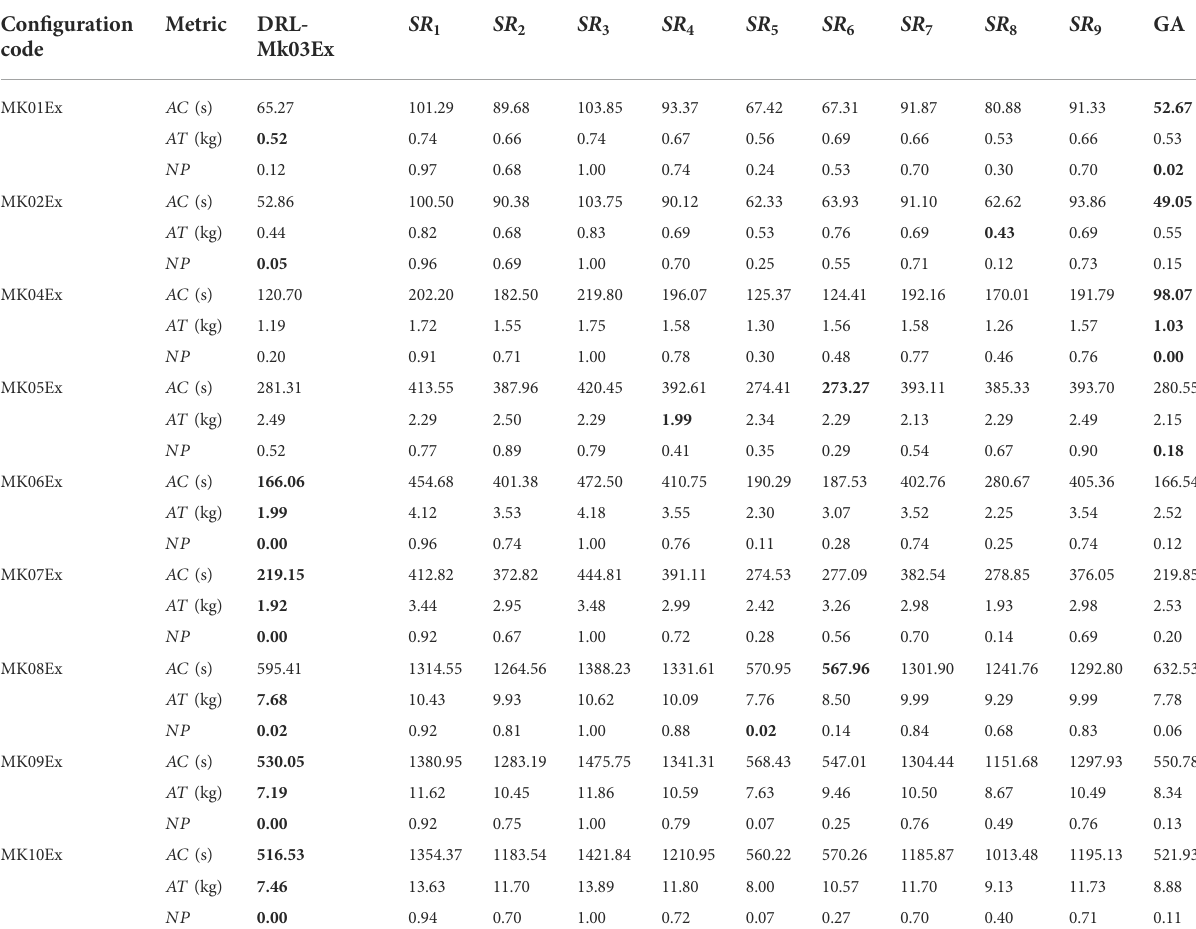
TABLE 7 Performance of DRL-Mk03Ex over the non-Mk03Ex instances. Con fi guration code